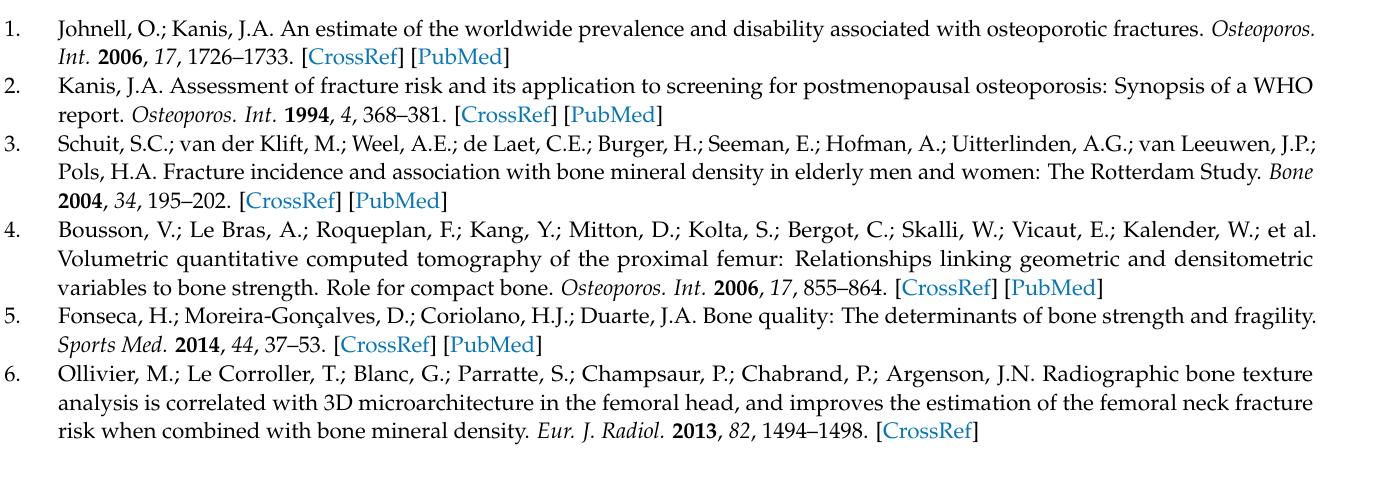
Table S2: Correlation between textural parameters and failure load; Table S3: Correlation between Table S4: Correlation between textural parameters and